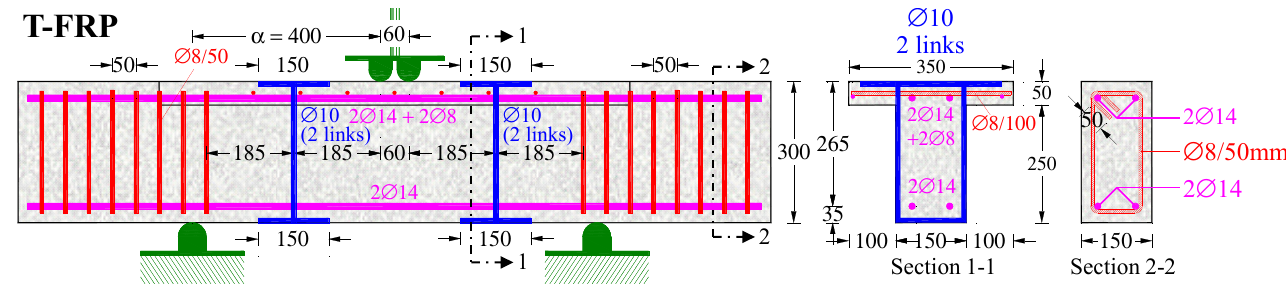
Figure 1. Geometry and reinforcement details of the beam R-FRP.